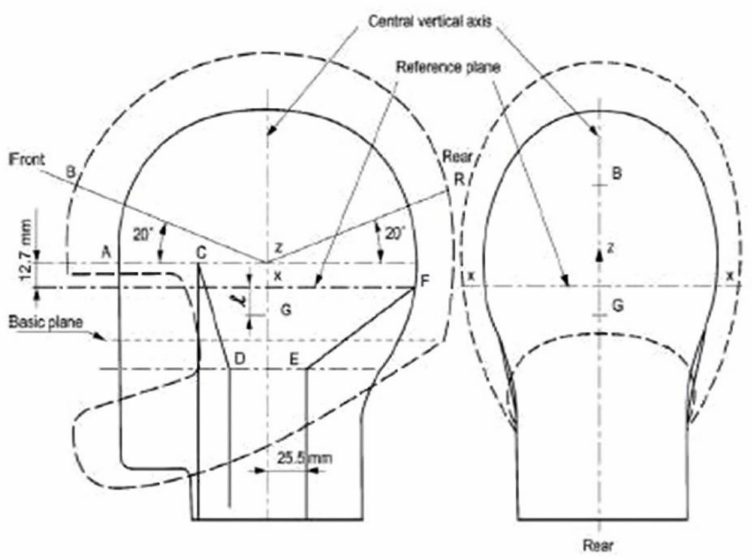
Figure 7. Placement of the flex sensors.